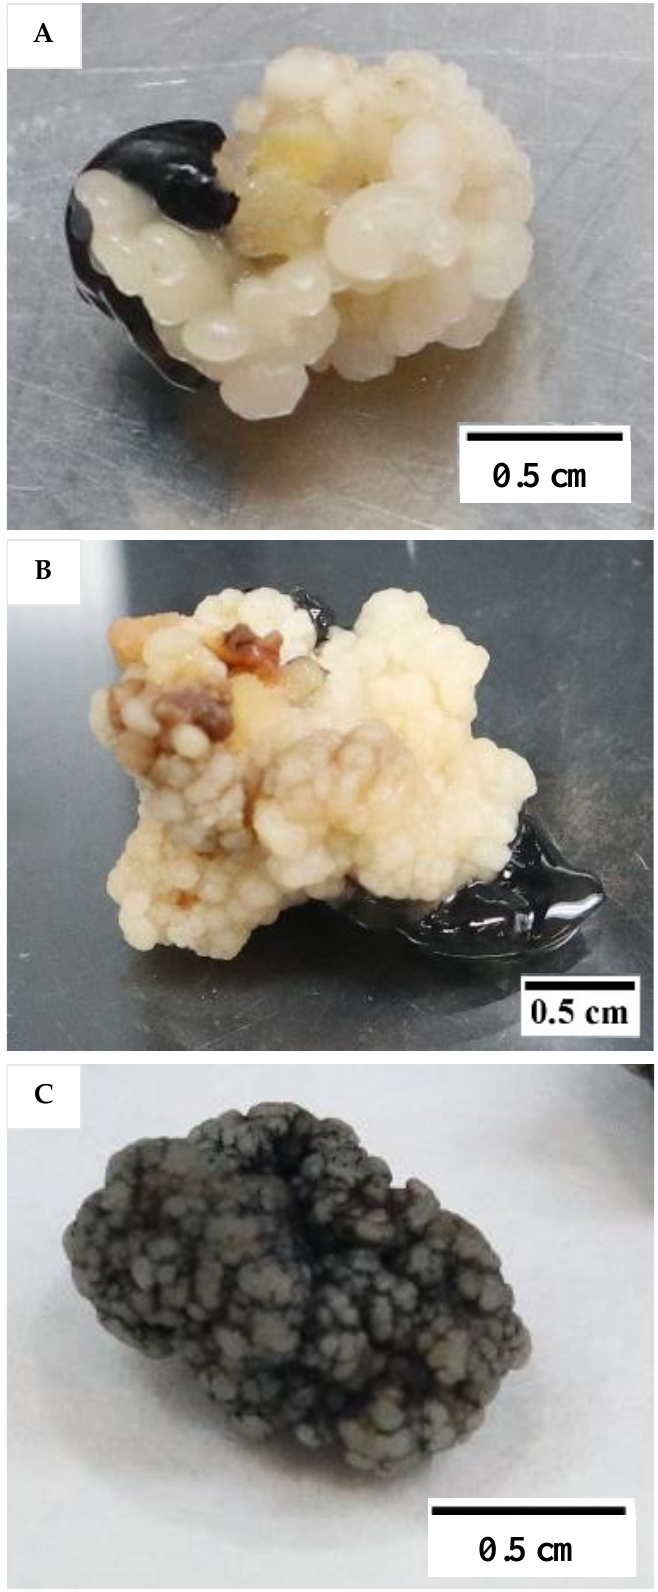
Figure 1. The type of compact callus formed. ( A ) Embryogenic callus (EC). ( B ) Non-EC. ( C ) Non- embryogenic callus appearing black in colour due to a coating of activated charcoal and produced from liquid medium.